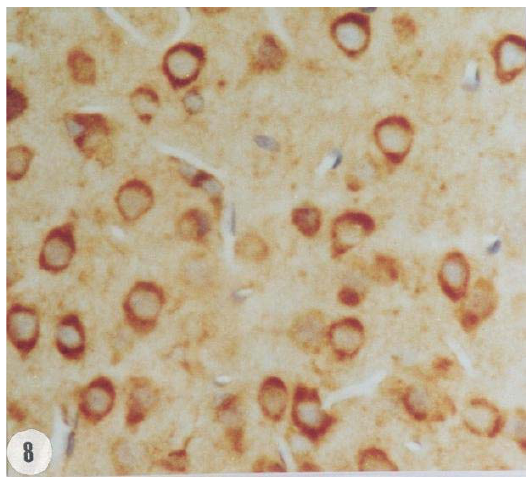
Figure 8. The highest NSE immunoexpression 72 hr after high dose envenoming.